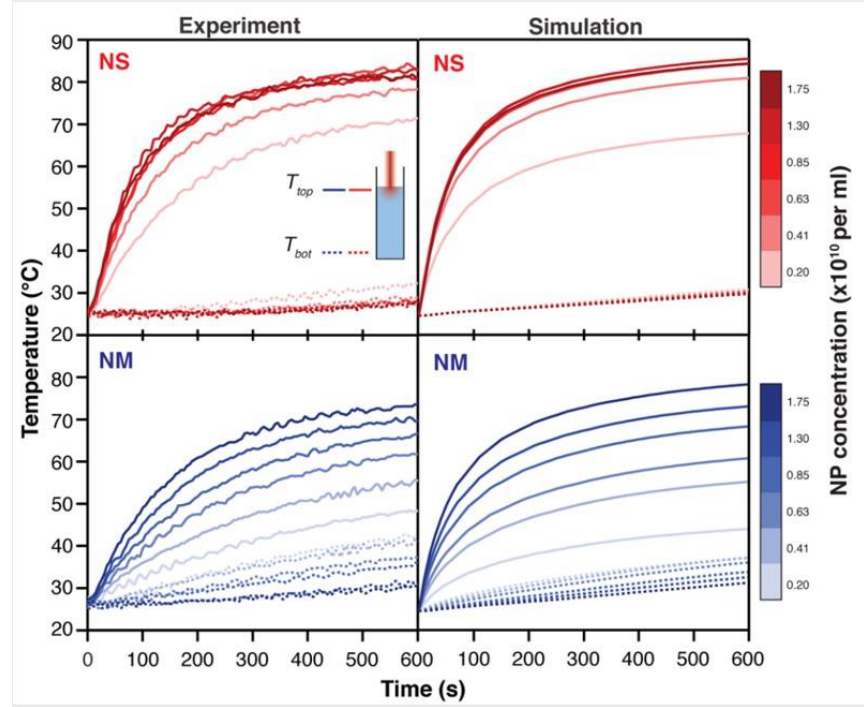
Figure 11. Numerical result of the temperature distribution in nanofluids [46]; 2014, ACS.